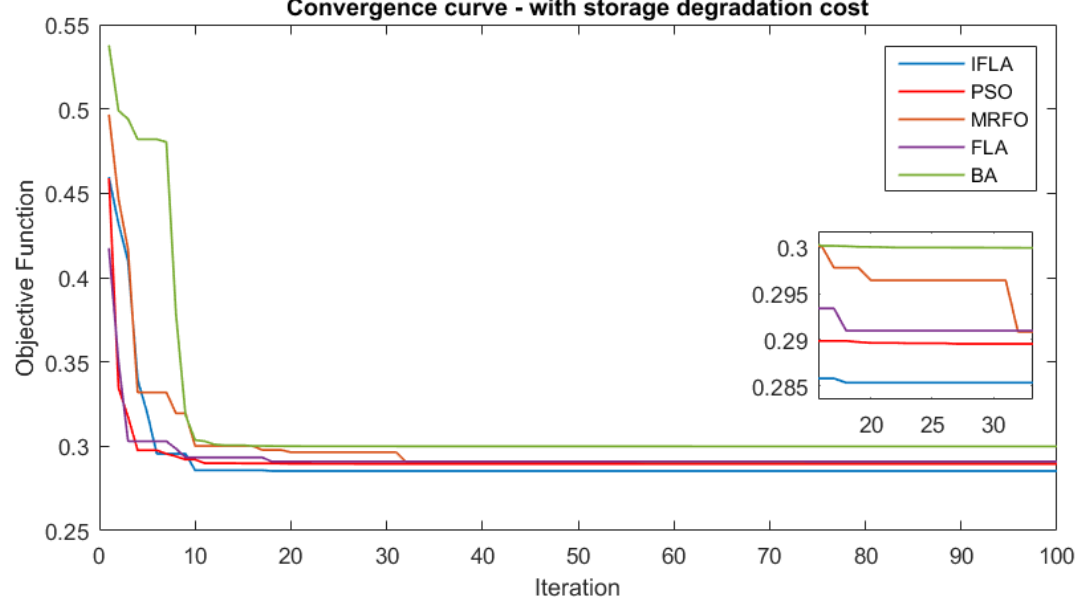
Figure 8. The convergence trend of various algorithms to solve the WG/Battery scheduling problem with storage degradation cost.